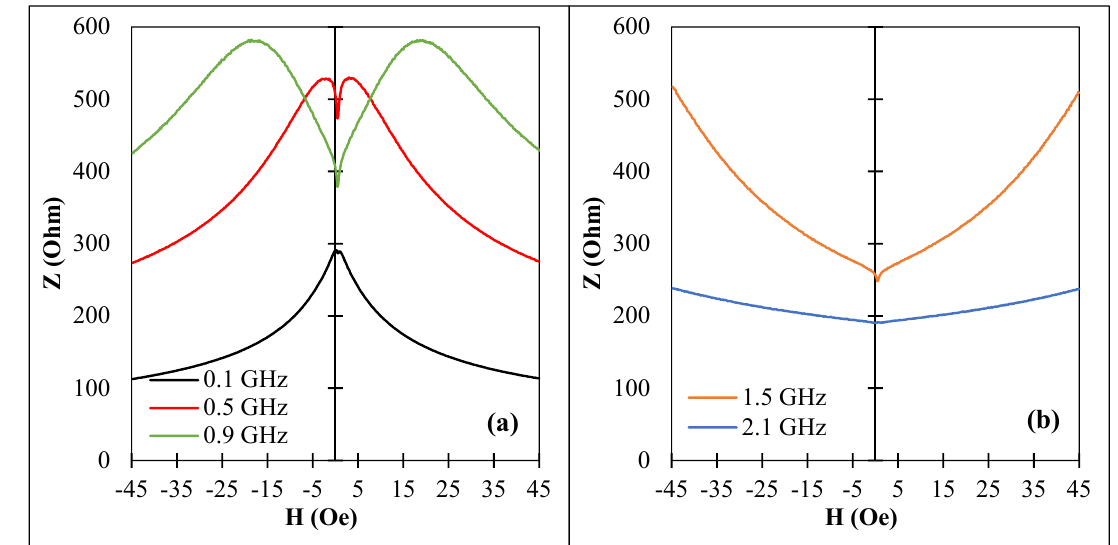
Figure 9. MI vs. magnetic field for amorphous Co 71 Fe 5 B 11 Si 10 Cr 3 microwires (sample No2) in as-prepared state for different frequencies: ( a ) 0.1 GHz to 0.9 GHz and ( b ) 1.5 GHz to 2.1 GHz. Z corresponds to the impedance amplitude.